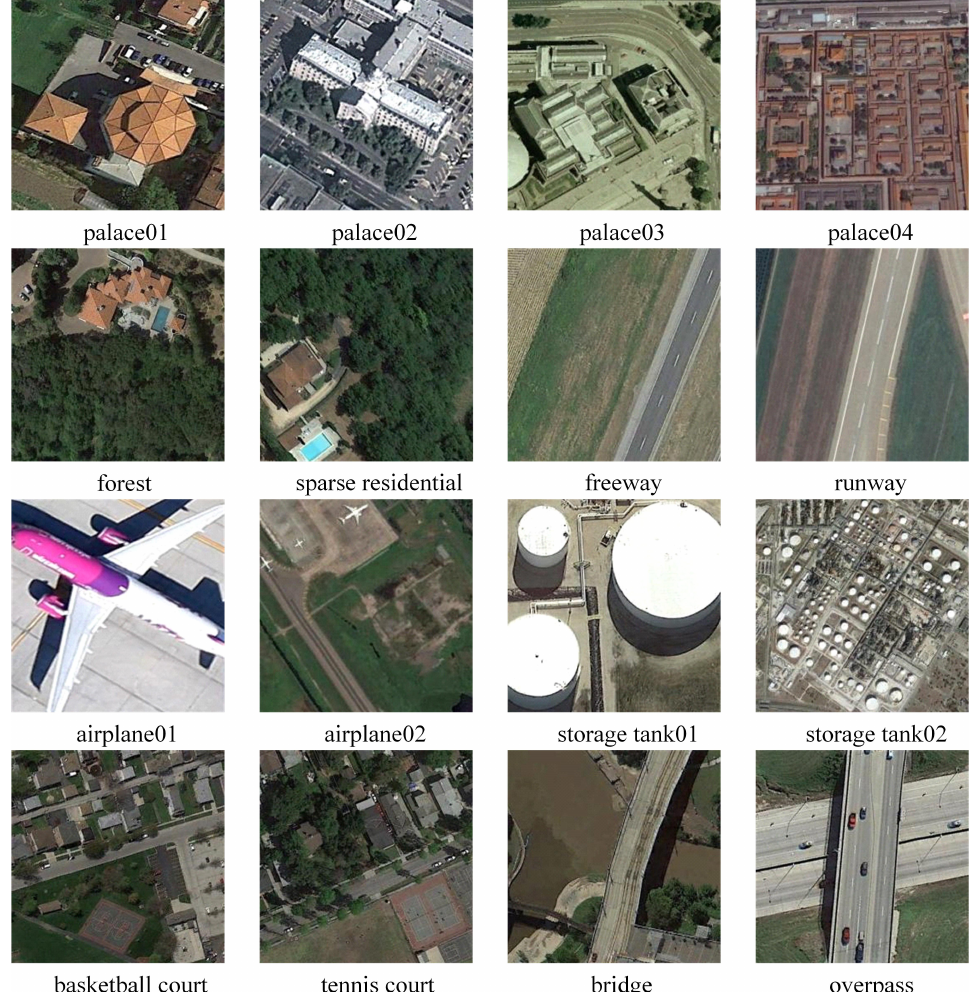
Figure 1. Challenges of RSISC. First row: large diversity within class. Second row: high similarity between classes. Third row: large variance of object/scene scales. Last row: coexistence of multi-class objects. These examples are from the NWPU-RESISC45 dataset